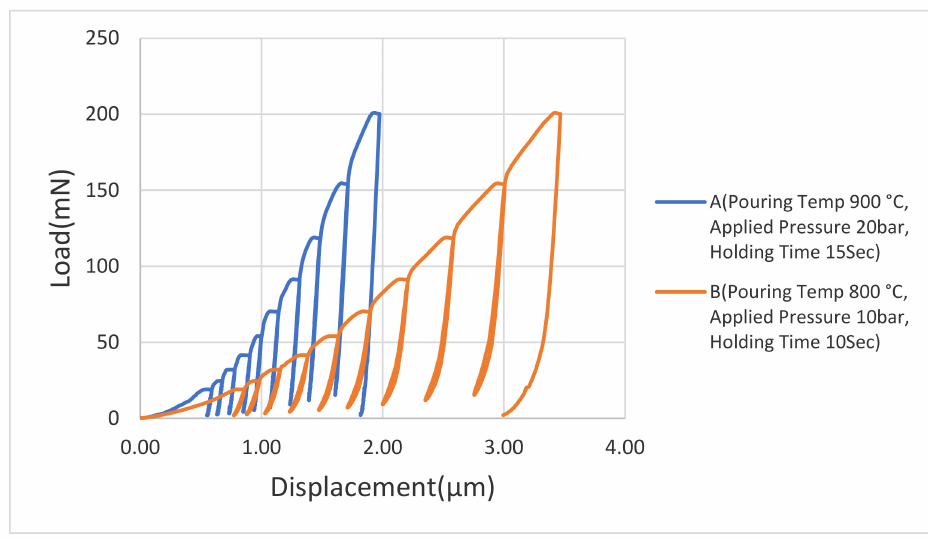
Figure 16. Load vs. displacement graph for cyclic